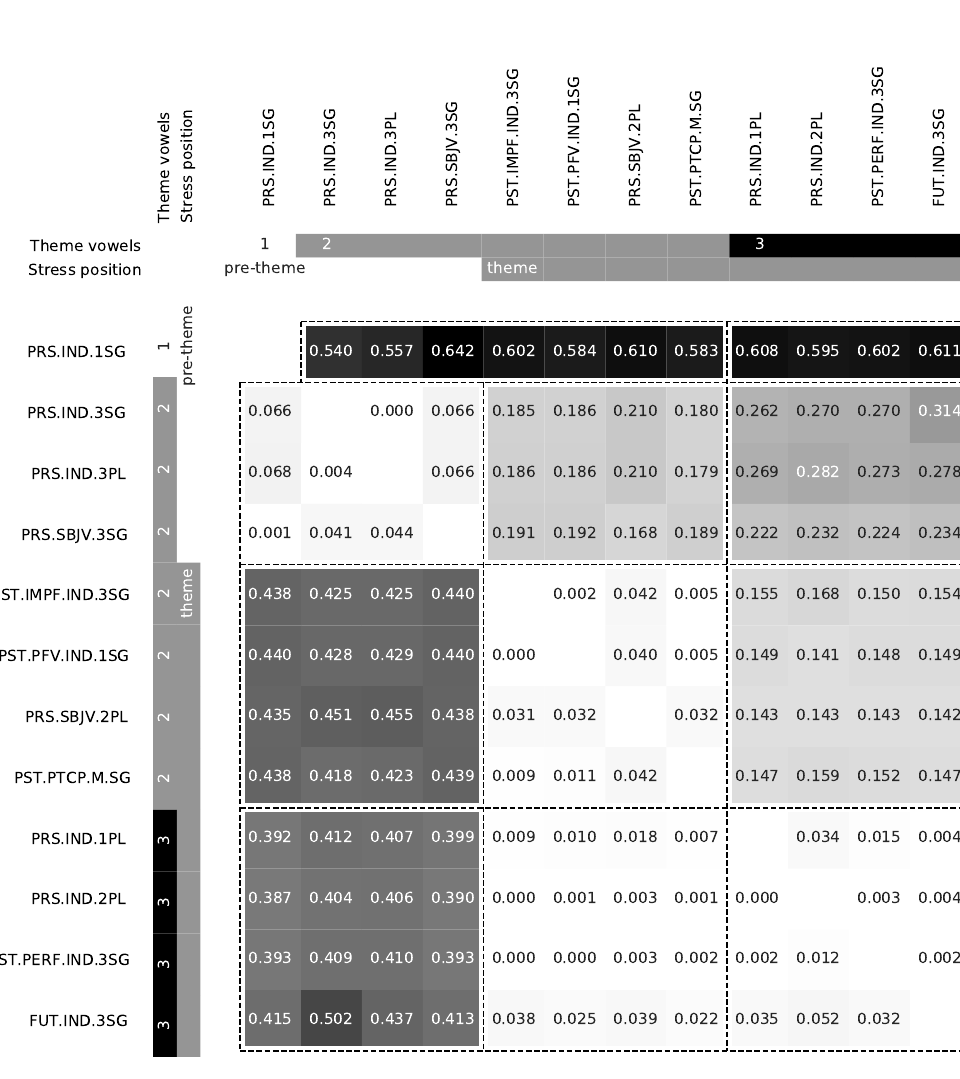
Figure 5: Combined sources of low